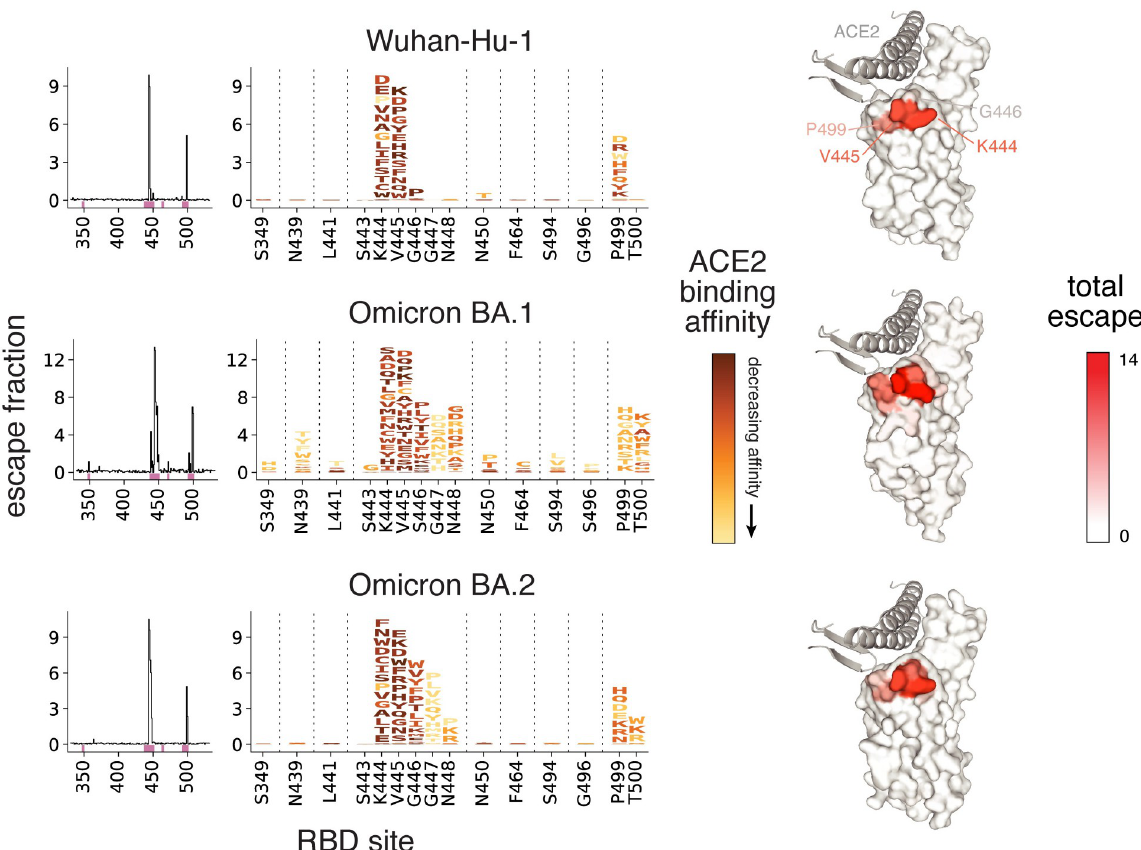
Fig 4. Complete maps of RBD mutations that escape LY-CoV1404 binding. Escape from LY-CoV1404 binding in the Wuhan-Hu-1 (top), Omicron BA.1 (middle), and Omicron BA.2 (bottom) backgrounds. The lineplots at left show the total escape of mutations at each site in the RBD. Sites of strong escape indicated by pink bars are shown at the mutation level in logoplots at center. Mutations are colored by their effects on ACE2 binding (scaled according to effects in each background). At right, antibody escape in each background is mapped to the RBD structure bound to ACE2 (key motifs in gray) from PDB 6M0J (Wuhan-Hu-1), 7WPB (Omicron BA.1), and 7XB0 (Omicron BA.2), respectively. “Escape fraction” represents the fraction of cells with that mutation that are sampled in an antibody-escape bin representing 10-fold decreased binding (S8A Fig). See S3 Data for underlying measurement